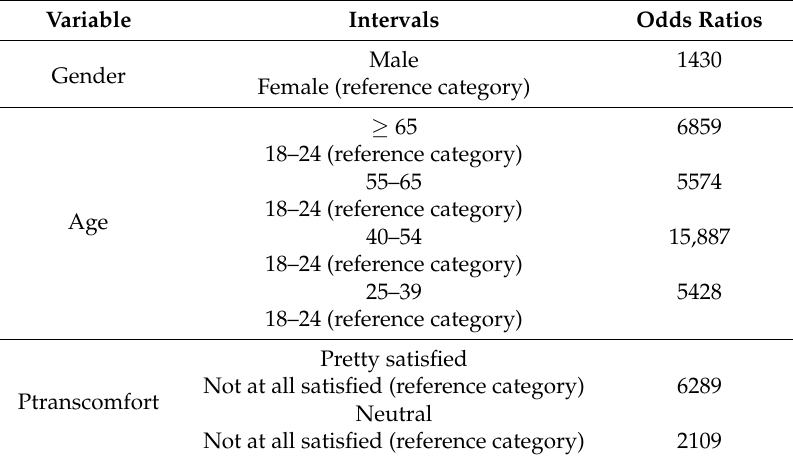
Table 6. Odds ratios results for the public transport